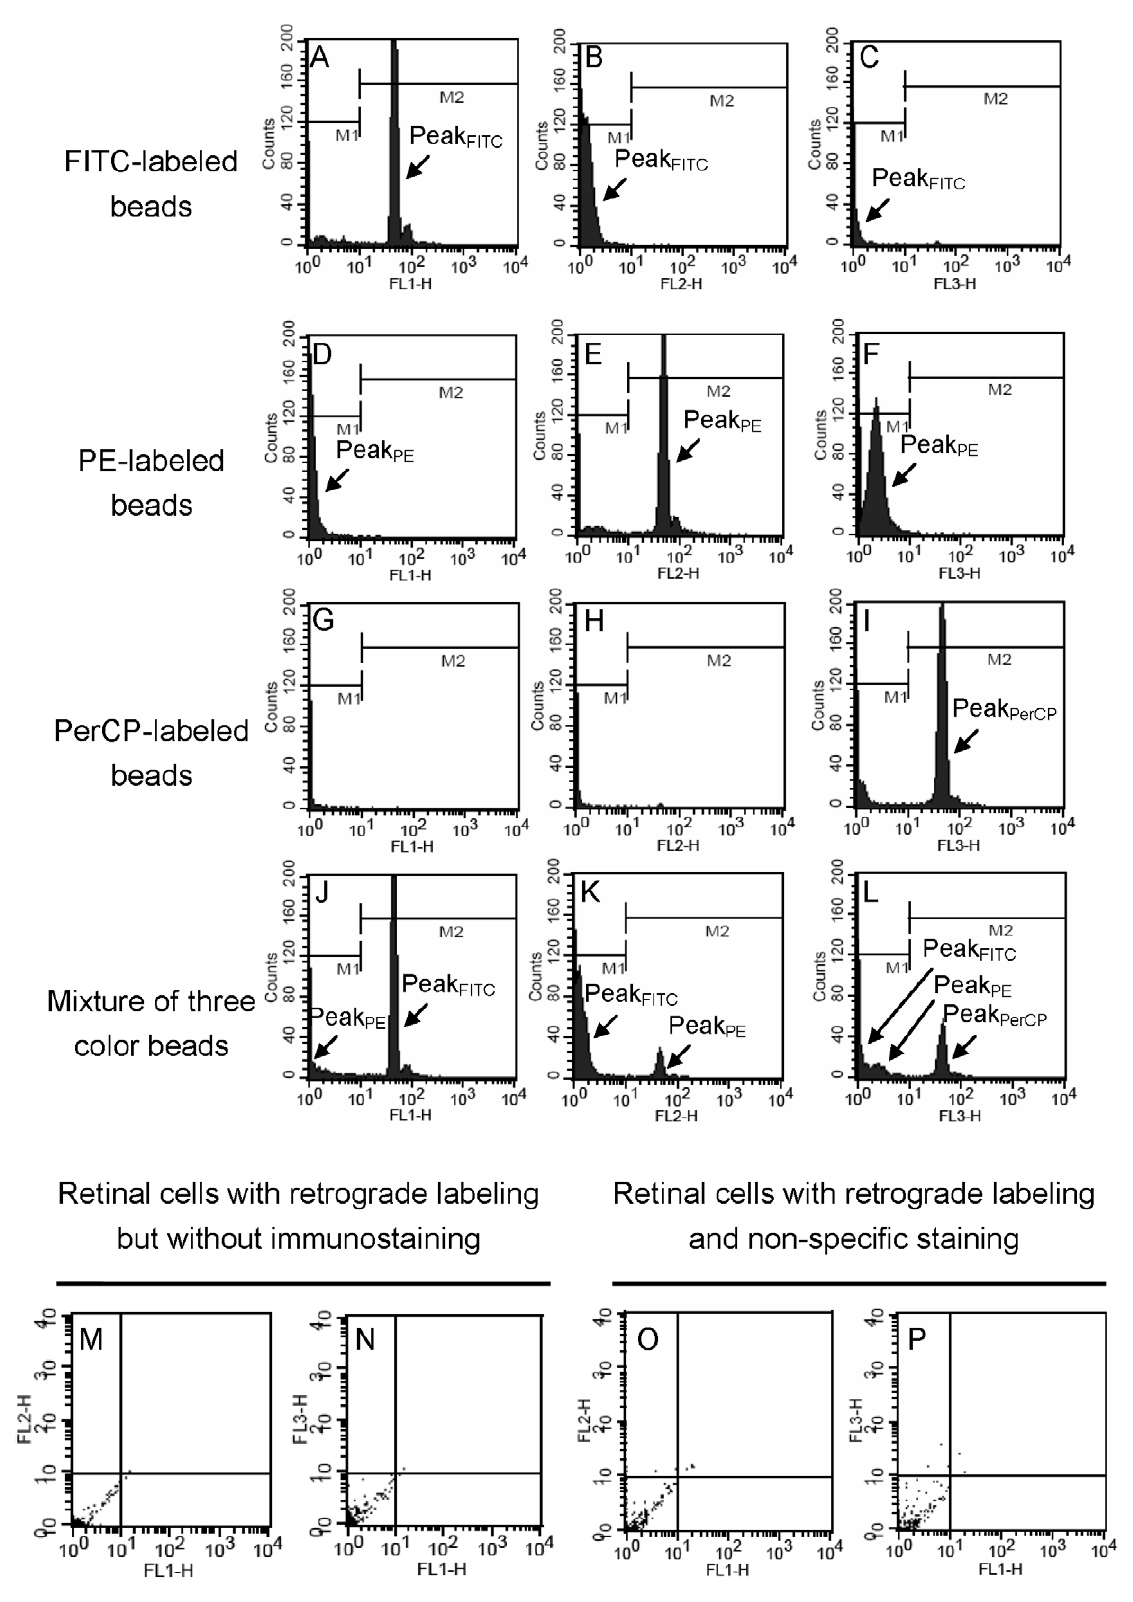
Figure 2. Preliminary analysis of flow cytometry. (A–L) Representative flow cytometric histograms of fluorescein isothiocyanate (FITC, Ex: 490 nm; Em: 520 nm)-labeled beads (A–C), phycoerythrin-R (PE, Ex: 495 nm; Em: 578 nm)-labeled beads (D–F), peridinin-chlorophyll protein (PerCP, Ex: 490 nm; Em: 677 nm)-labeled beads (G–I) and the equal-amount mixture of three color beads (J–L). The FL-1H histogram (A) shows the positive